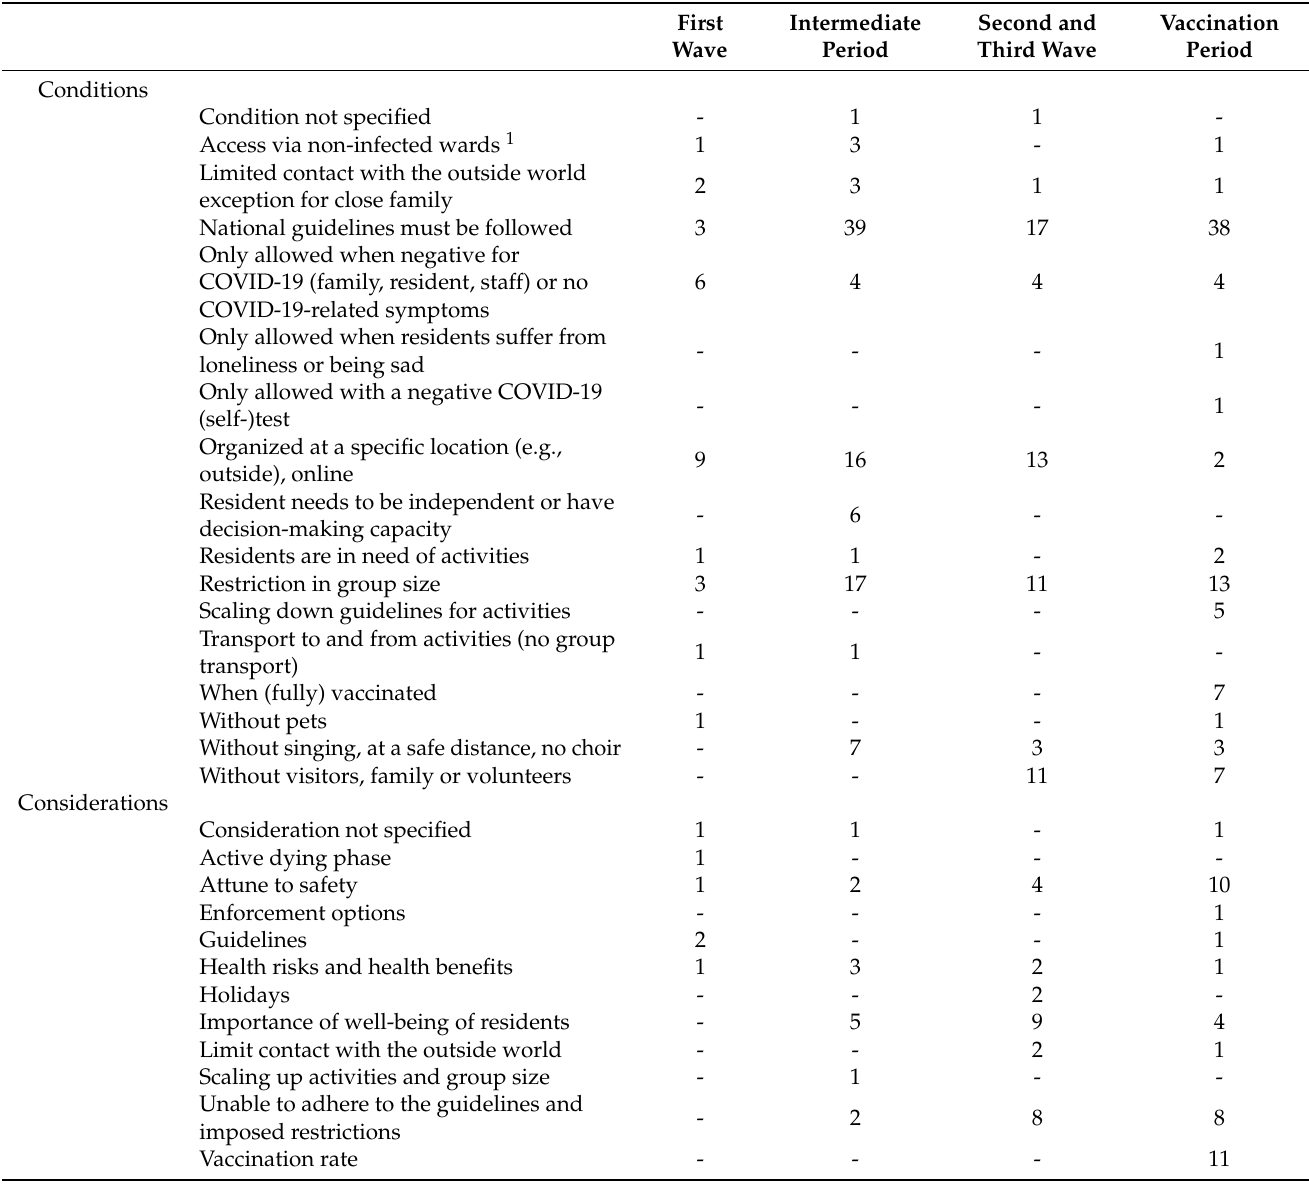
Table 1. Overview of the mentioned conditions and considerations per time